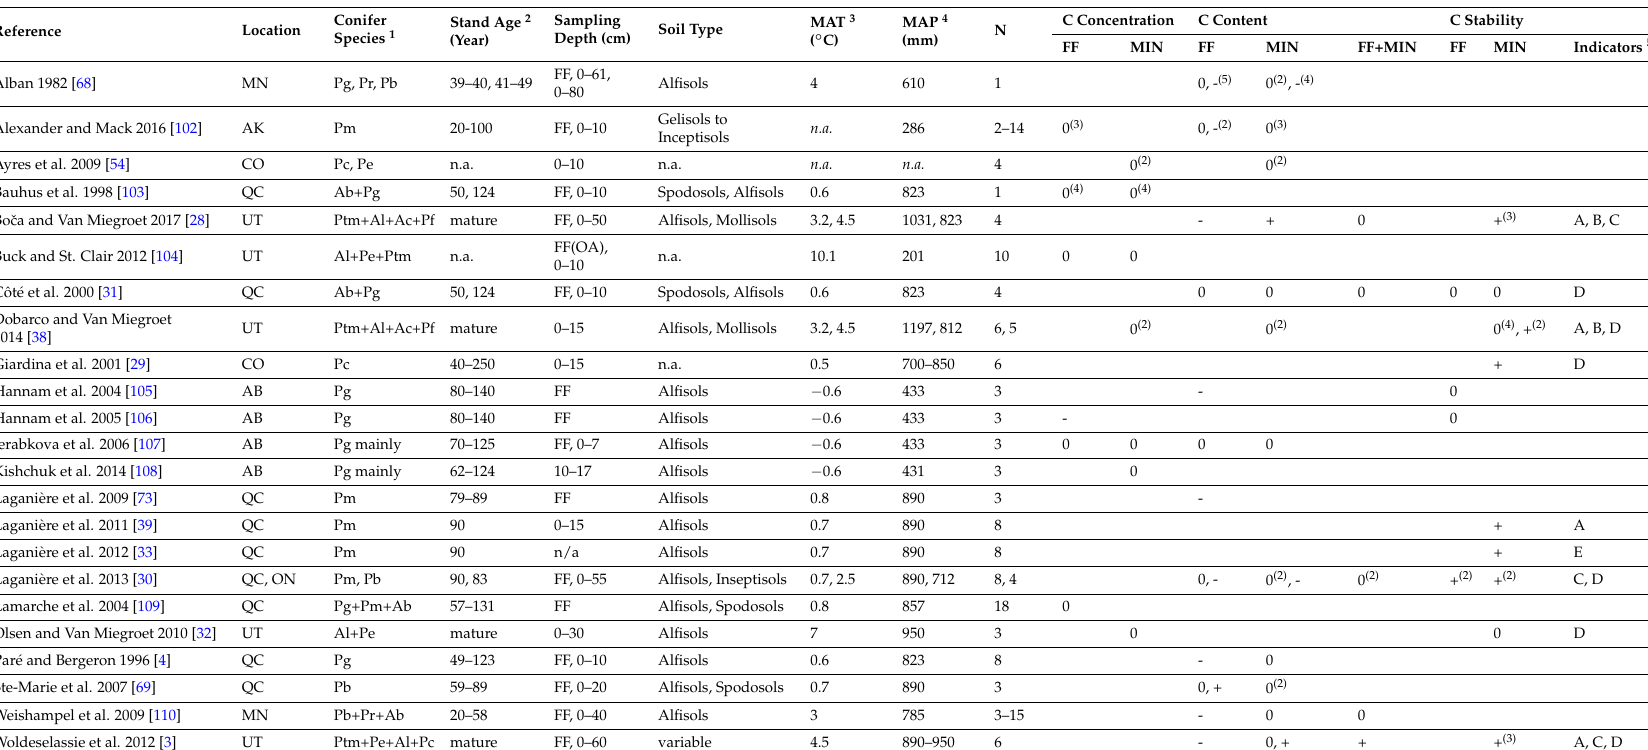
Table A1. Description of the studies included this systematic literature review and summary of results. Aspen causes either an increase (+), a decrease ( − ), or no change (0) in forest floor (FF) and mineral (MIN) soil C concentration, content, and stability relative to conifers. When a similar effect (+, − , or 0) is observed more than once per reference, the number of cases showing this effect is indicated in brackets next to the effect